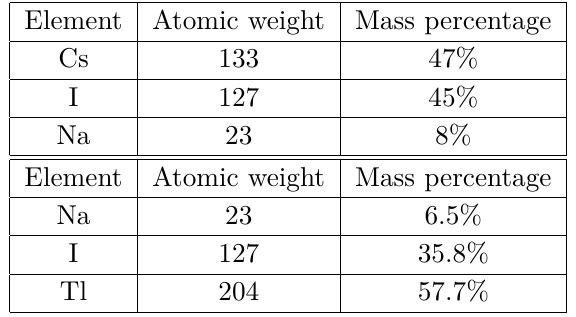
Table 3 . Mass percentage of each element in CsI[Na] and